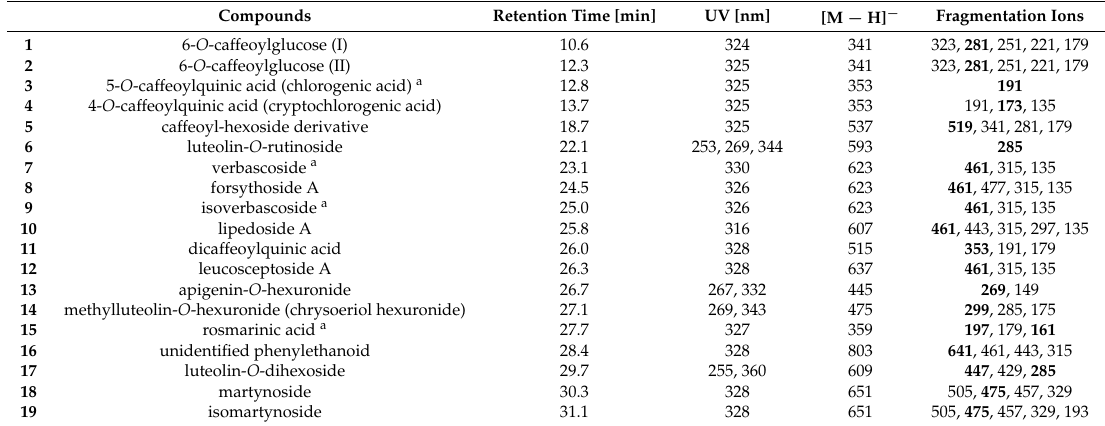
Table 1. UPLC-DAD-ESI-MS n data of detected and identified polyphenolic compounds in extracts of aerial parts of S.